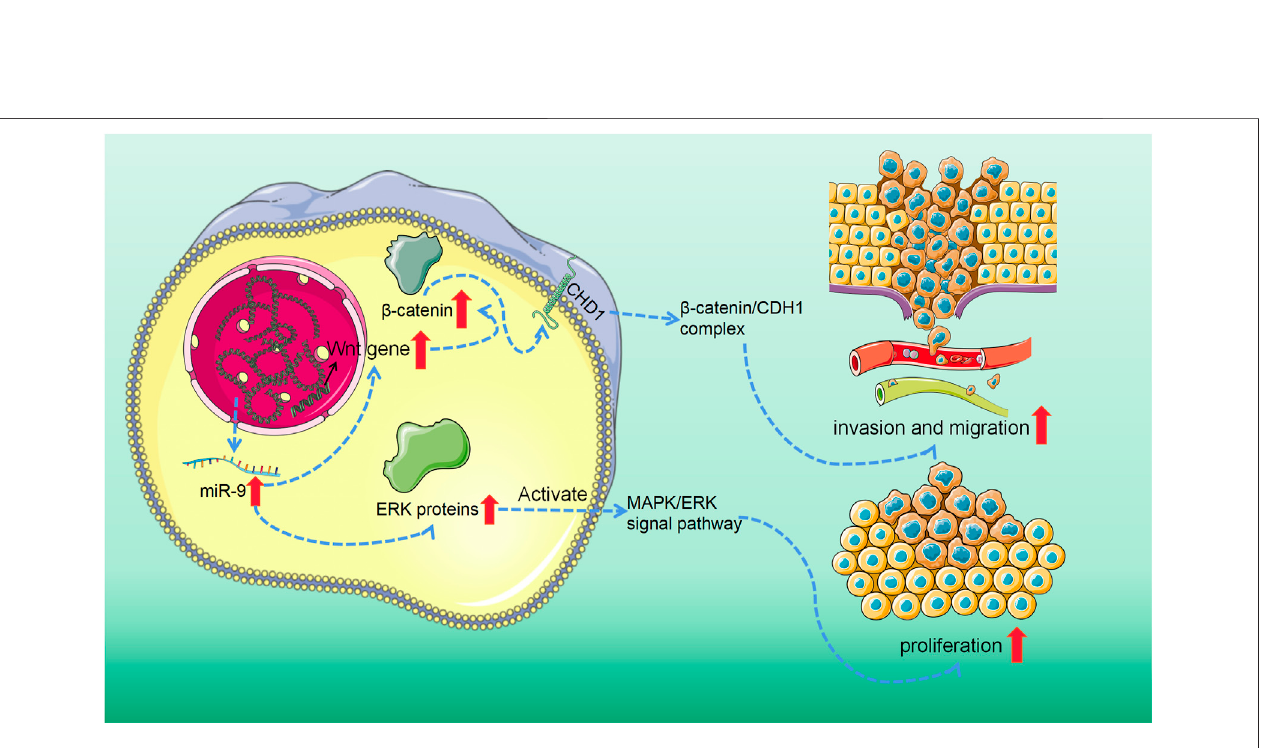
FIGURE 3 | MiR-9 overexpression activated mitogen-activated protein kinase/extracellular signal-reduced kinase (MAPK/ERK) and Wnt/ β -catenin signaling pathway. On the one hand, in the Wnt/ β -catenin signaling system, the abnormally activated Wnt gene in tumor tissue can reduce the phosphorylation degradation of β - catenin. The accumulating β -catenin may then attach to CDH1 to create a complex, which may aid tumor cell invasion and metastasis. On the other hand, the overexpression of miR-9 can signi fi cantly promote the expression of ERK protein and then activate MAPK/ERK signaling pathway, to stimulate the proliferation of SS cells and inhibit